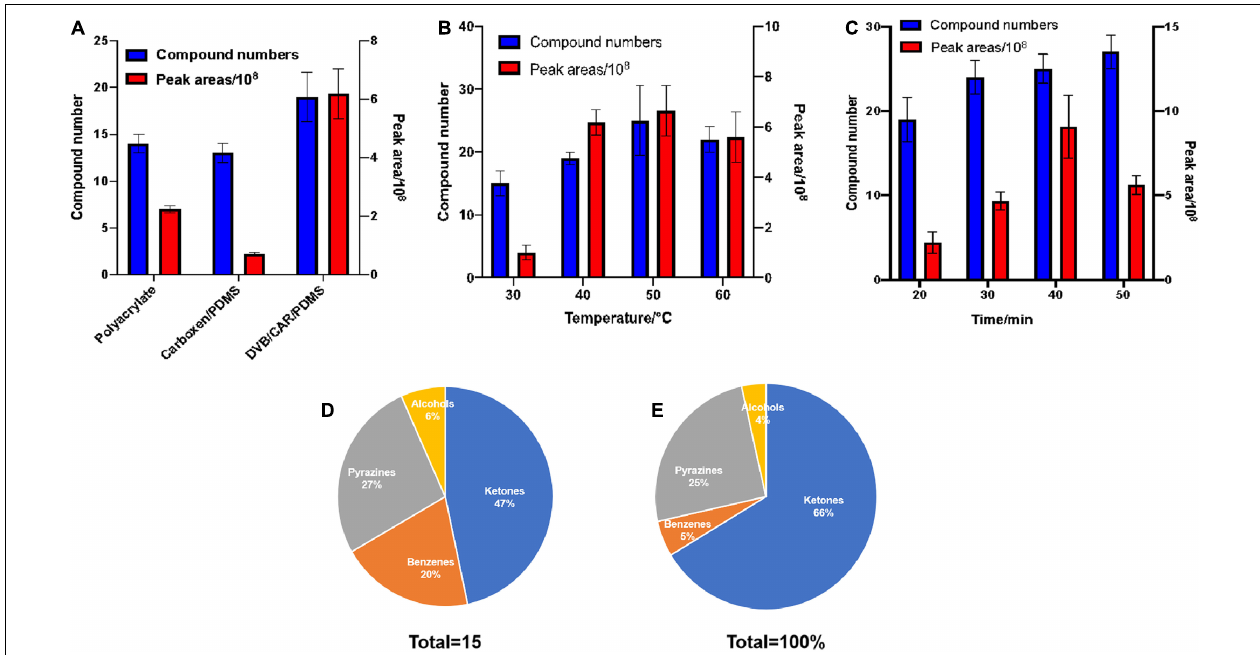
FIGURE 1 | Optimization of collection conditions with HP-SPME for the GC-MS determination of VOCs. The effects of extraction fibers, time, and temperature on HS-SPME results for VOCs produced by B. subtilis ZD01 were evaluated. Total number of compounds and peak areas of VOCs served as the evaluation index. (A) Extraction fibers. (B) Extraction temperature. (C) Extraction time. After extraction, the analytes were identified by GC–MS. The compounds were classified into different classes based on their structures and functional groups, and we calculated the total peak areas of each of the four classes. (D) Classification of VOCs produced by ZD01. (E) Peak areas of four identified classes of VOCs from ZD01. The results are presented as the means ± SDs ( n =